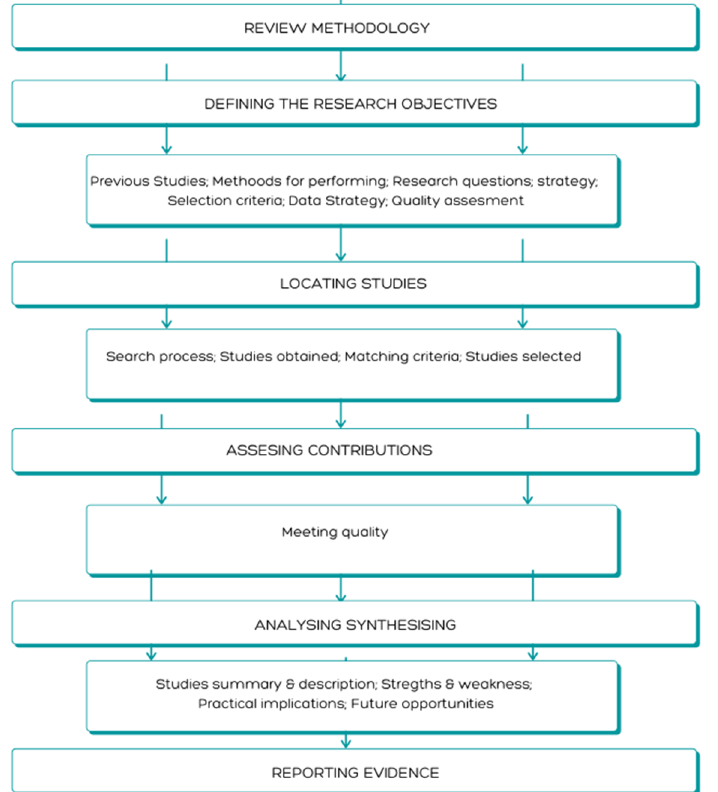
Figure 2. Research methodology for this study.